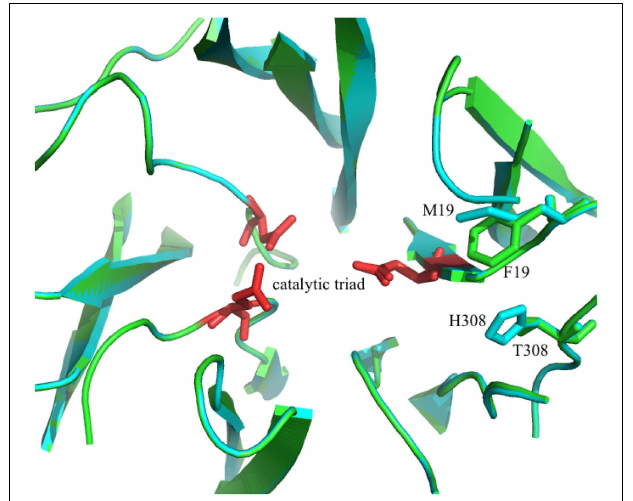
FIGURE 2 | 3D model of the superimposed catalytic sites of the 1-FFT of Vd (blue) and Ht (green) (homology models, based on the 3D structure of 6-SST/6-SFT from Pachysandra terminalis Lammens et al., 2012). The amino acids of the catalytic triad are shown in red and the two mutations sites, M19F and H308T, are labeled.